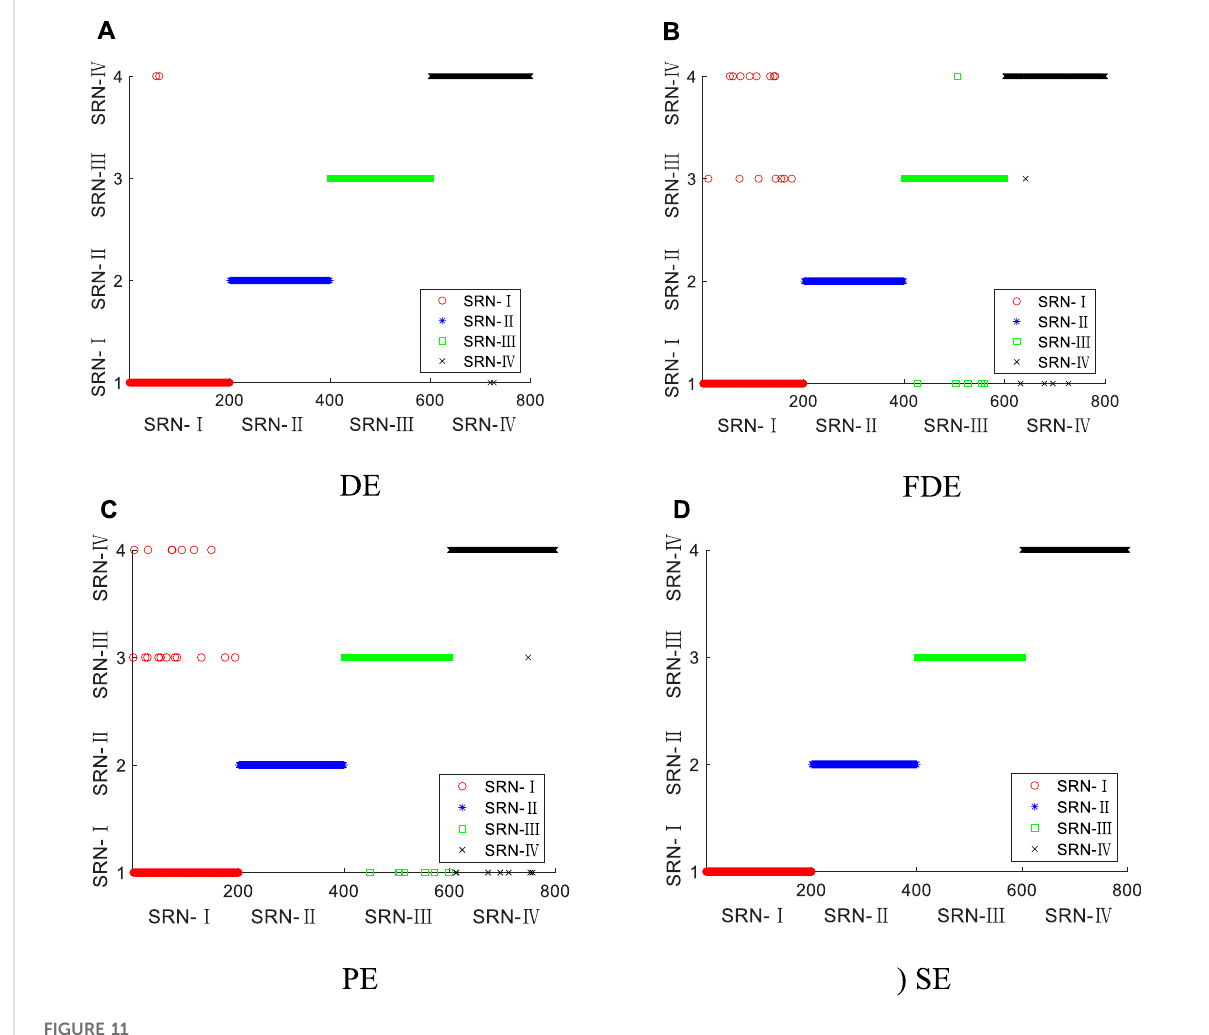
FIGURE 11 Three-feature classi fi cation results of the four types of entropy for the four types of SRN. (A) DE (B) FDE (C) PE (D)